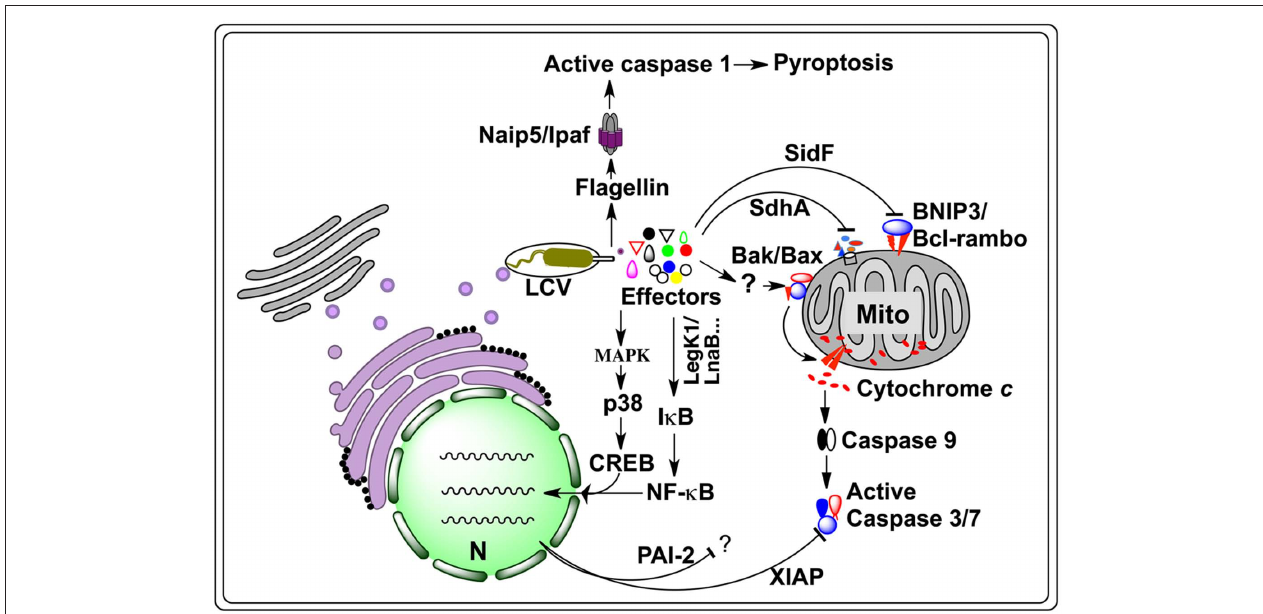
targeting caspases 3 and 7. Activation of the MAP kinase pathway by another set of unknown effectors can lead to similar effects. A third set of proteins such as SidF and SdhA, which inhibit host cell death by targeting pro-apoptotic proteins BNIP3 and Bcl-rambo or by unknown mechanisms. In non-permissive mouse macrophages, flagellin reached the cytosol probably via the Dot/Icm transporter is sensed by the NLR receptor Naip5, which together with Ipaf and the inflammasome activates caspase-1, leading to pyroptotic cell death. CREB, cAMP response element-binding protein; LCV, Legionella containing vacuole; MAPK, mitogen-activated protein kinases; Mito, mitochondrion; N, nucleus; Naip5, NLR family, apoptosis inhibitory protein 5; PAI-2, plasminogen activator inhibitor-2; XIAP, X-linked inhibitor of apoptosis